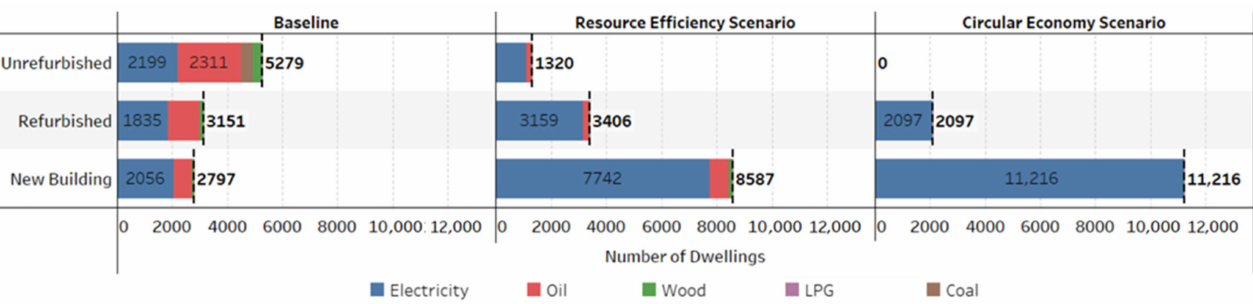
Figure 2. Number of dwellings and fuel types by house archetypes and specifications for baseline and future